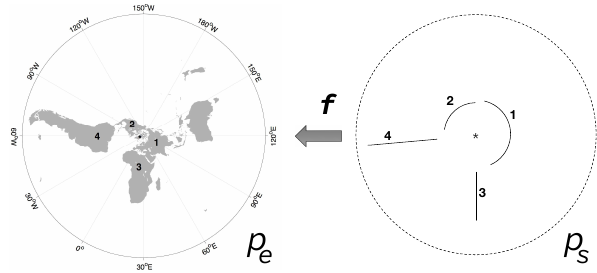
Figure 11. Conformal mapping between p e and p s